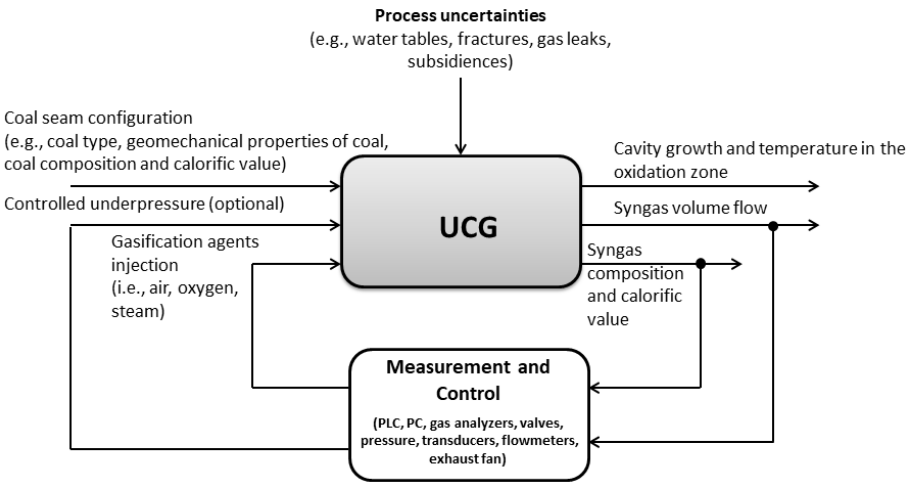
Figure 2. The UCG system configuration.